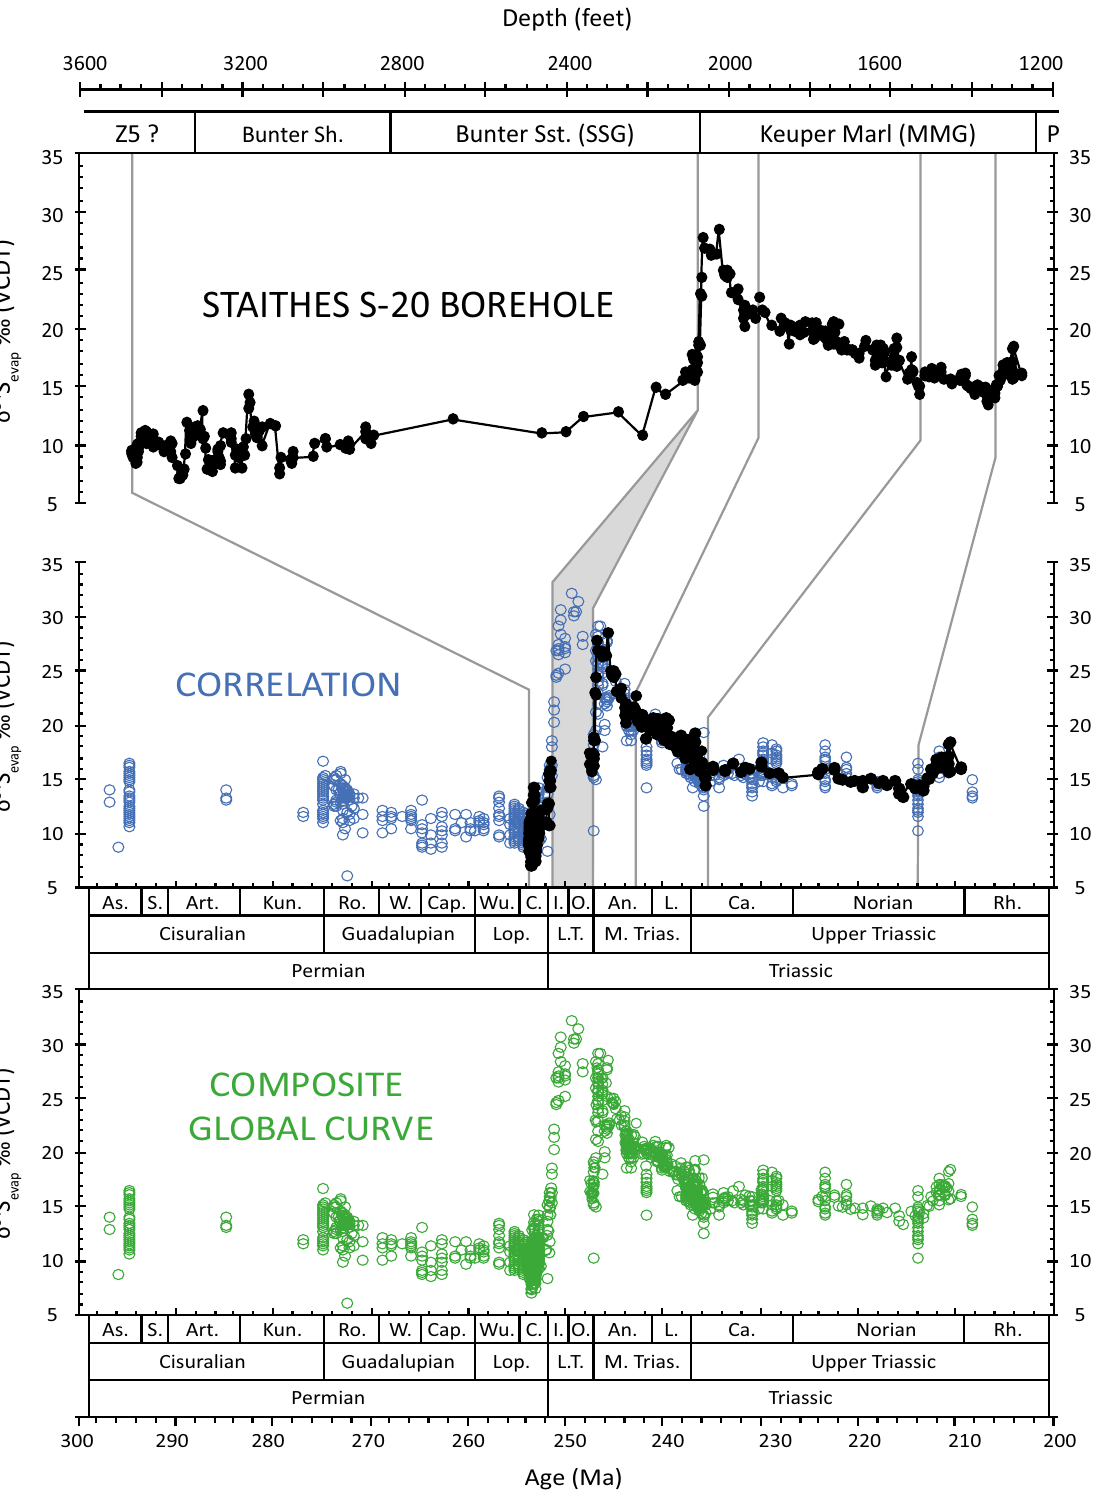
Figure 2. Sulphur isotope records derived from sedimentary evaporites from the Staithes S-20 borehole, northeast Yorkshire (top). The lithostratigraphy of the borehole is also displayed. The correlation between the global composite curve and the Staithes record (middle) is based primarily upon the trends and inflection points in the isotope records. The Staithes record was combined with the global record to produce a single composite curve (bottom; see